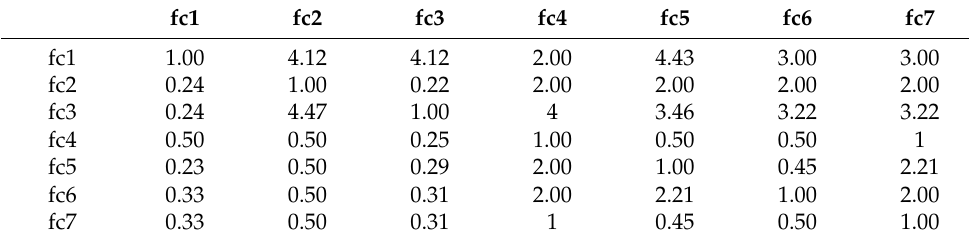
Table 3. Pair-wise comparison matrix of the sub-criteria of functionality.